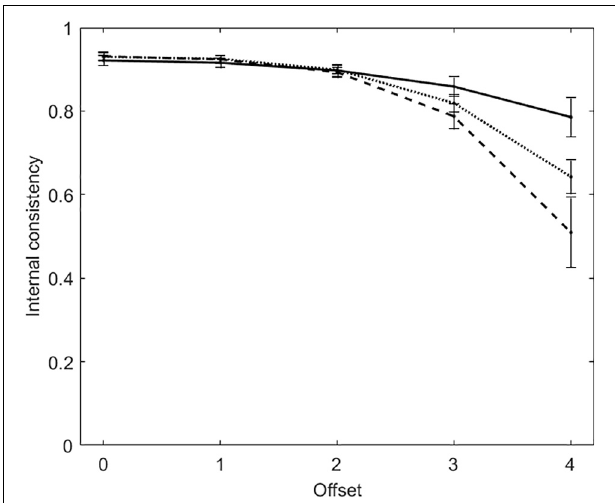
FIGURE 3 | Average internal consistency (and standard deviation) for each of the five offset conditions in the tests with polytomous items. The solid line represents α , the dashed line represents R, the dotted line represents the true-measure-based internal consistency